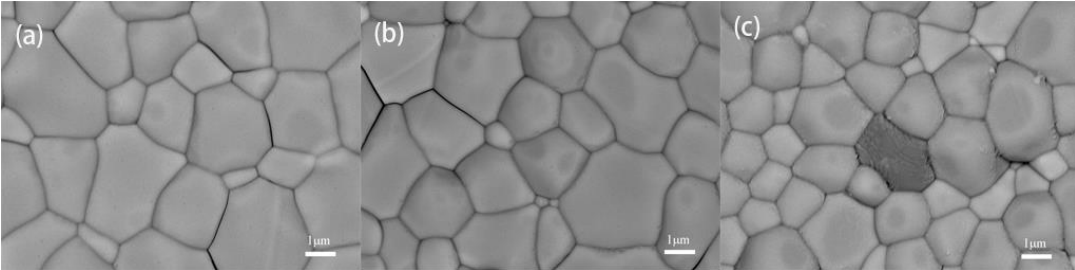
Figure 5. SEM images (shown in BSE) for the surface of ( a ) 1 wt.% NiO internally doped LCNO, ( b ) 2 wt.% NiO internally doped LCNO and ( c ) 5 wt.% NiO internally doped LCNO.